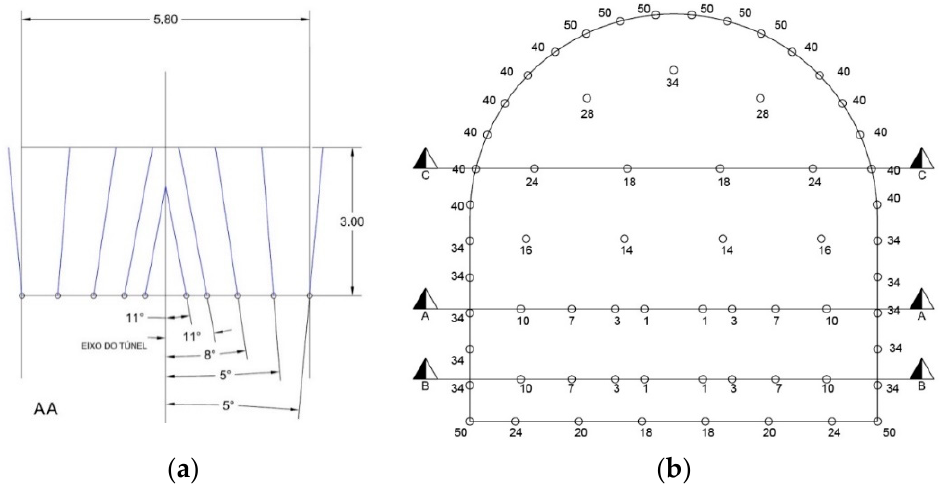
Figure 15. ( a , b ) Scheme of a V-cut. pull: 3.0 m; surface: 30 m 2 ; total charge: 119 kg; detonating cord 40 g/m: 90 m; powder factor: 1.32 kg/m 3 ; holes’ diameter: 45 mm; delay time: 25 ms. ( b ) The numbers refer to the delay sequence [4].